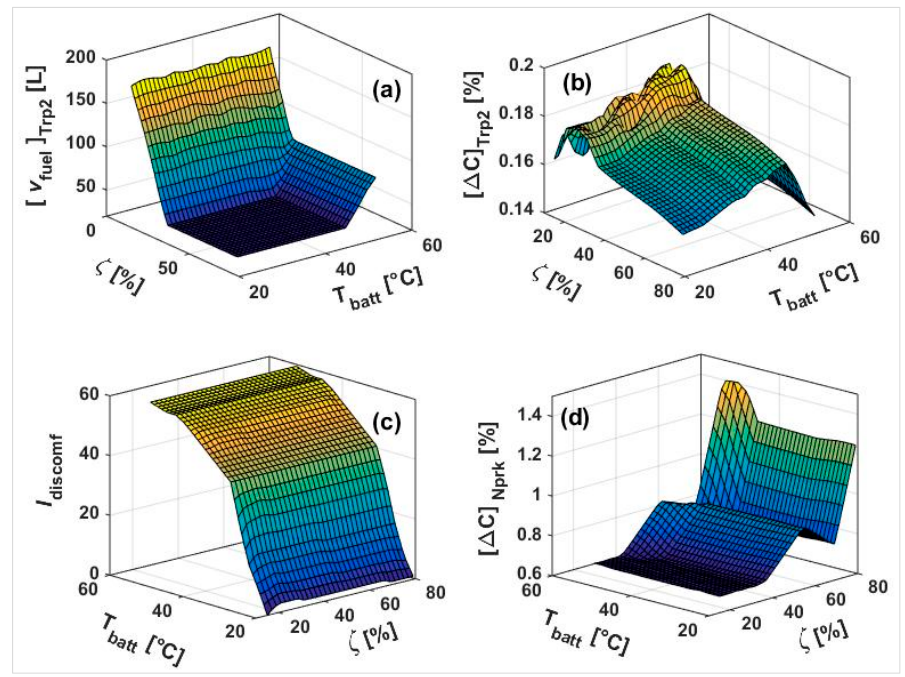
(cid:16) (cid:17) t Dprk : ( a ) fuel consumption in Trip 2;